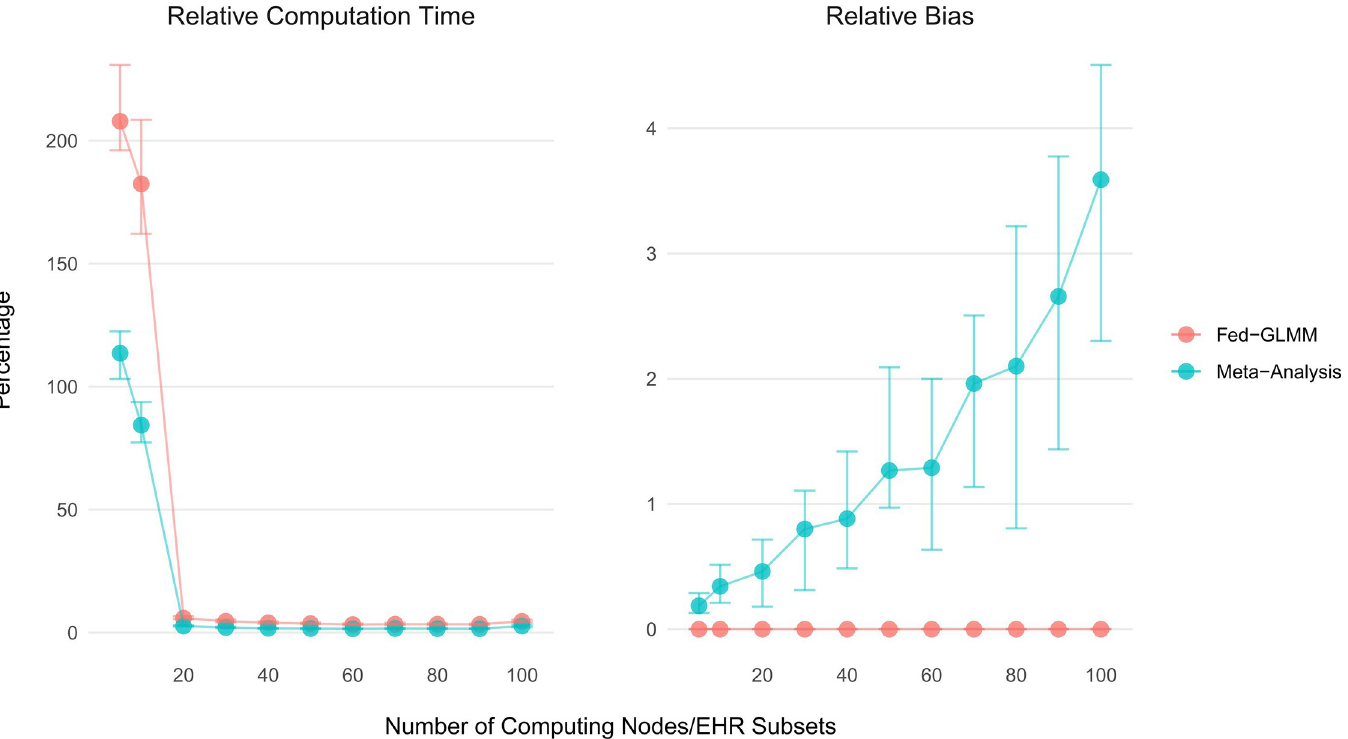
Fig 3. Comparison of computation time and estimate accuracy for Fed-GLMM and meta-analysis relative to gold-standard pooled analysis with increasing computing nodes/EHR subsets. We compared Fed-GLMM with meta-analysis using the ratio (in percentage) of computation time over the pooled analysis. For each simulation replicate, we generated one single centralized EHR. The underlying model has a binary outcome, a binary exposure, three more covariates and a patient-level random intercept. We considered dividing the centralized EHR data into varying numbers of subsets to be computed in parallel. Both Fed-GLMM and the meta-analysis spent less than 5% of the computation time required by the pooled analysis with the number of computing nodes greater than 20. However, the meta-analysis had increased relative bias for the exposure coefficient when the number of subsets increased, while Fed-GLMM retained its accuracy relative to the pooled analysis. The points and bars represent median and interquartile range of computation time and relative bias in percentage